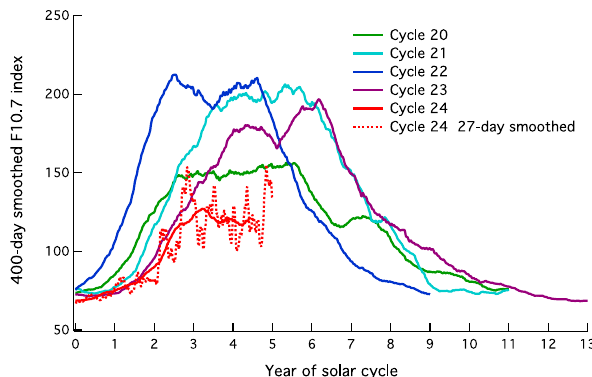
Figure 6. Sunspot number records since the beginning of SC19. The 13-month smoothed monthly SSN for each cycle is shown (solid lines), and the monthly SSN of SC24 till September 2013 is dis- played (dotted line with symbols) as well.